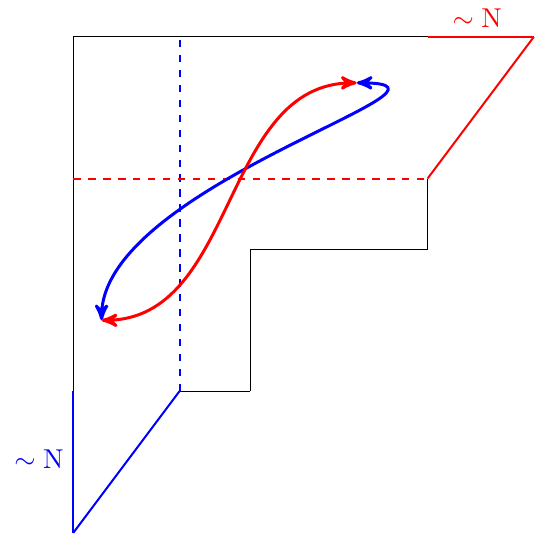
Figure 25 . Schematic representation of a quantum state describing a pair of entangled superstars (triangular excitations at the edges) separated by a large energy